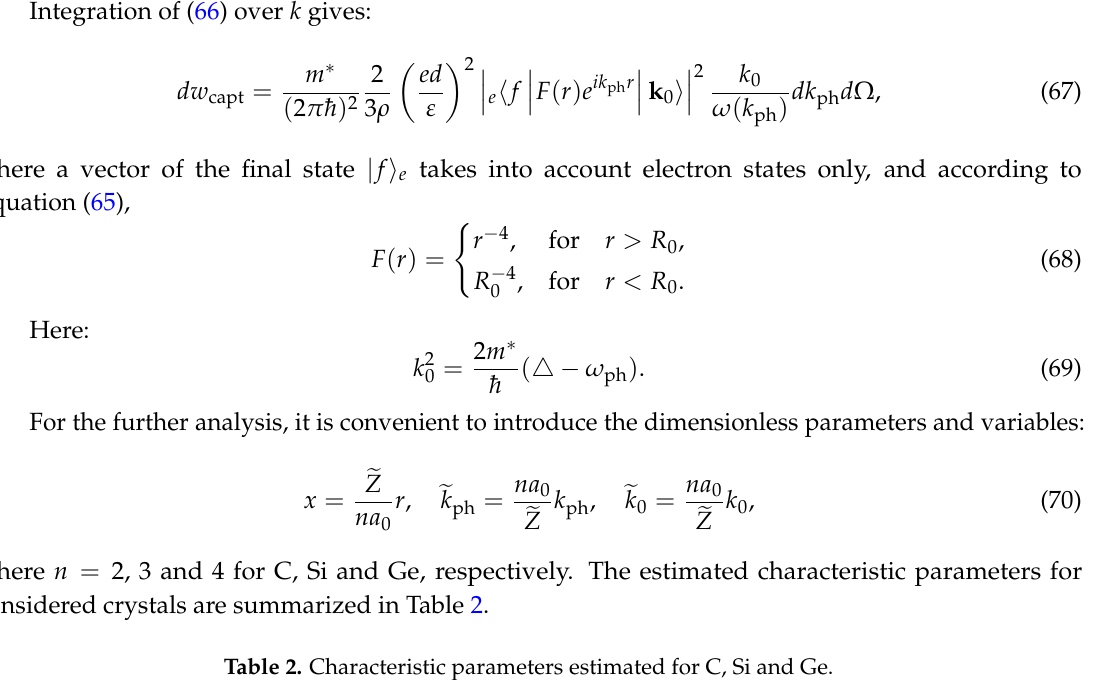
Table 2. Characteristic parameters estimated for C, Si and